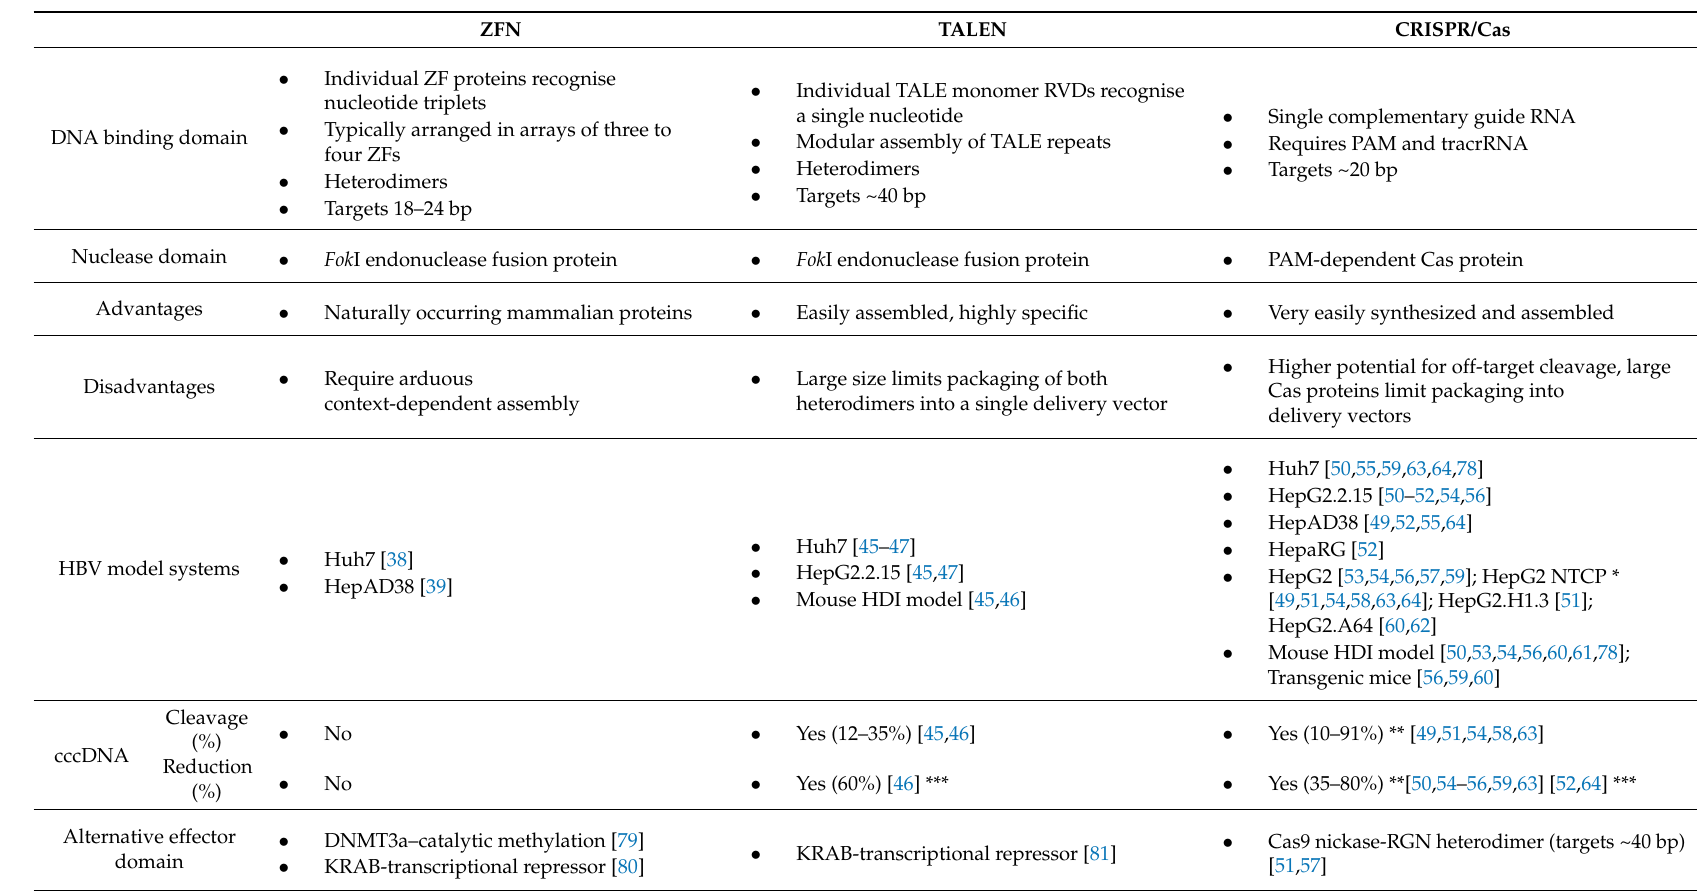
Table 1. Overview of designer nucleases for HBV gene therapy. RVDs: repeat-variable di-residues; tracrRNA: trans -activating crRNA; HDI: hydrodynamic injection; RGN: RNA-guided nucleases ZFN